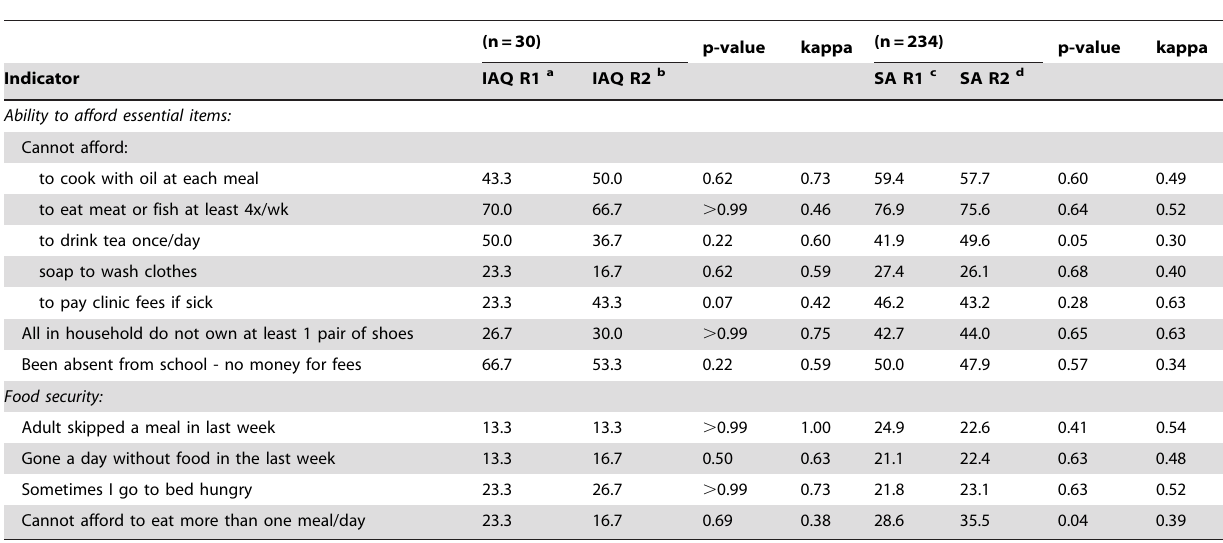
Table 5. Proportion of respondents reporting each socio-economic indicator in each round and the extent of agreement between each round for respondents using the same mode of questionnaire delivery in Rounds 1 and 2.